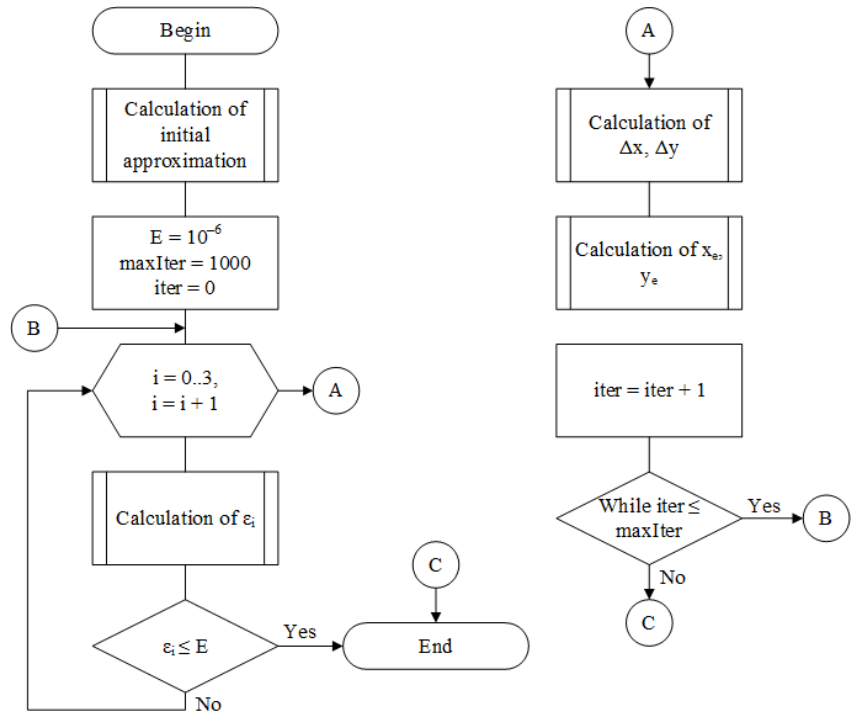
Figure 2. The algorithm of calculating the approximate coordinates of a token.